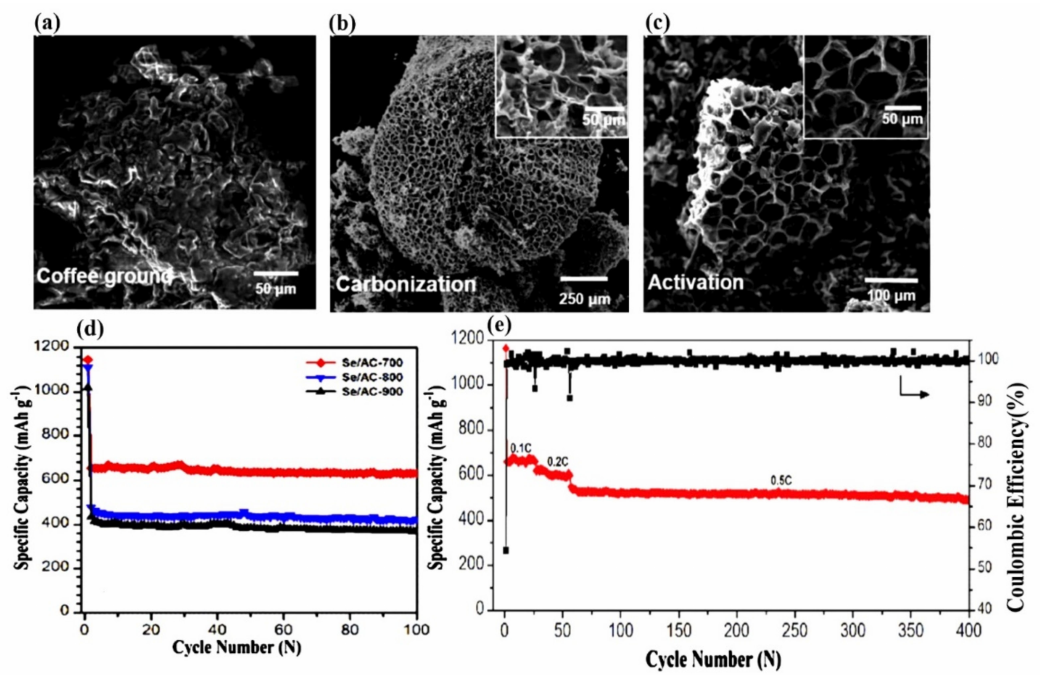
Figure 6. SEM images of waste coffee grounds (WCG) ( a ) as received, ( b ) after carbonization, and ( c ) after activation (AC-700). ( d ) Cycling stability, ( e ) long cycling performance of Se/AC-700 measured at 0.5 C. Reproduced with permission from [52], Copyright 2019, Elsevier